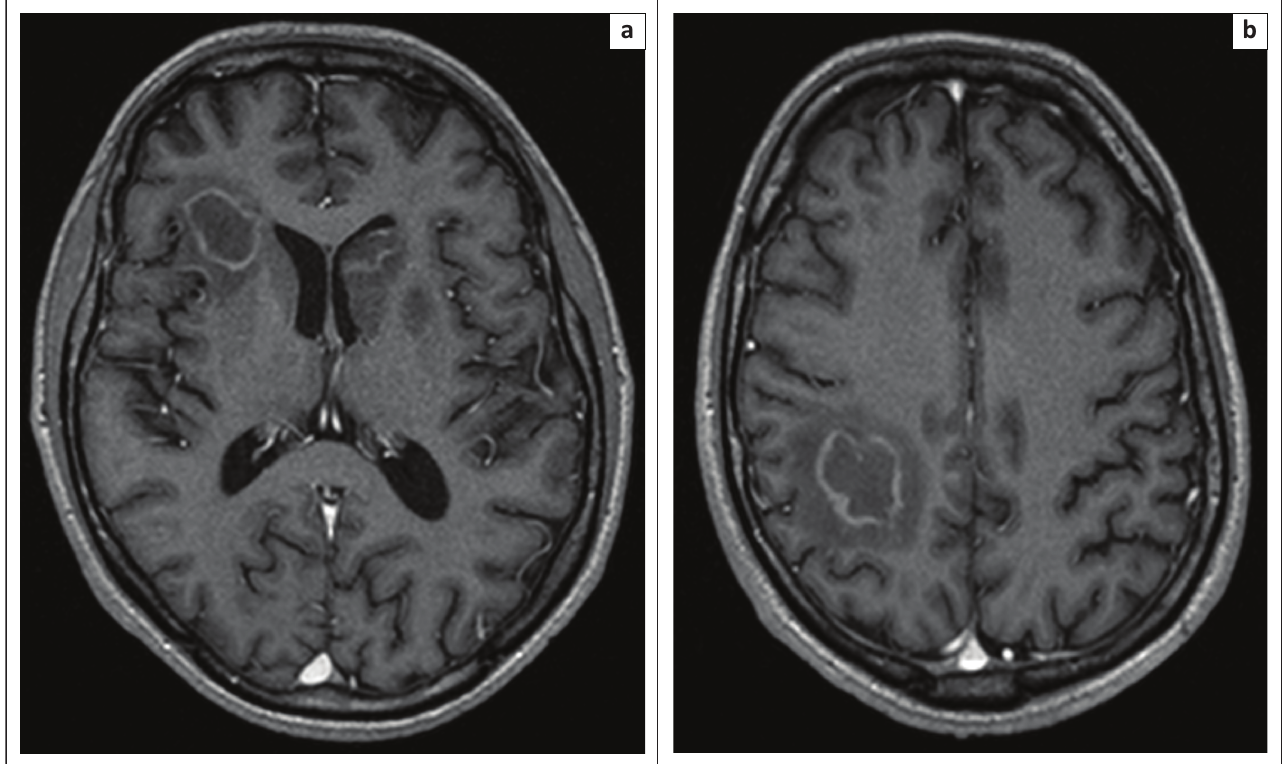
FIGURE 1: Post-gadolinium T1 contrast enhanced axial slices from MRI brain performed 2 days following the initial clinical presentation. Multiple ring-enhancing lesions are seen within the right frontal (a), left basal ganglia and corticomedullary junction within the right parietal lobe (b). Effacement of anterior horn of the left lateral ventricle is noted